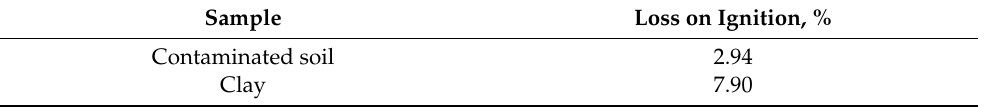
Table 5. Loss on ignition of the contaminated soil and